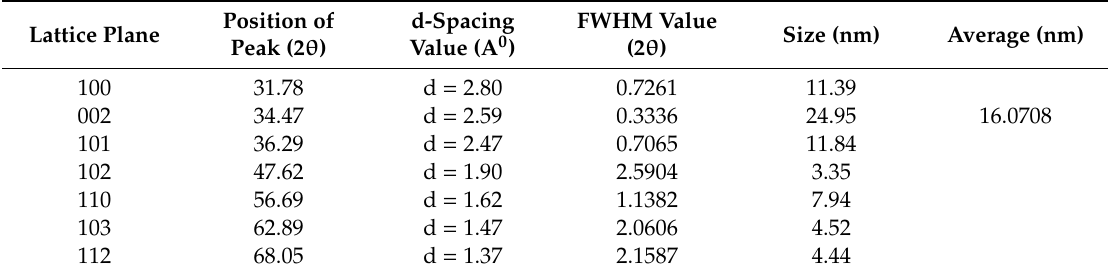
Table 3. Crystalline size analysis of DM -ZnO-I3C-NE using an XRD